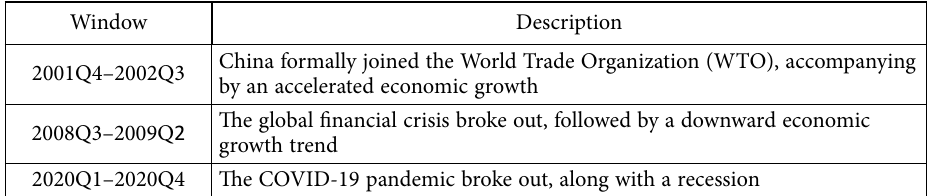
Table 2. Three landmark